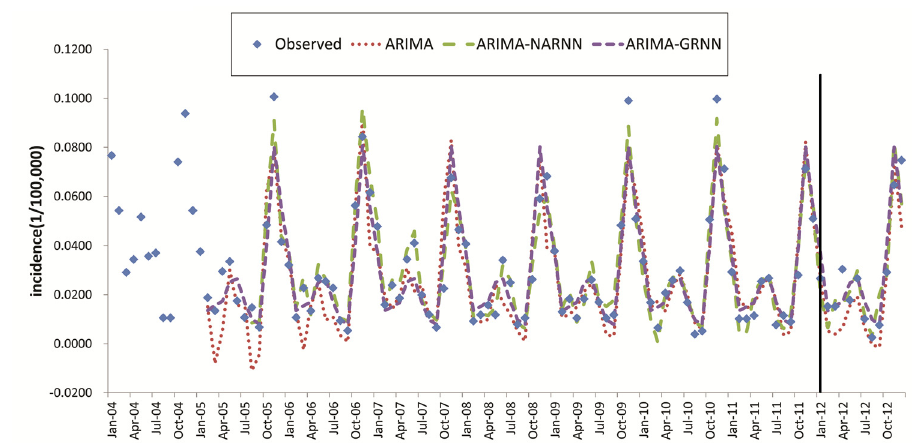
Fig 7. The observed HFRS incidence and modeling and forecasting values simulated by ARIMA, ARIMA-NARNN and ARIMA-GRNN model. The data set was divided into modeling and forecasting data set with a vertical line; the left is the modeling stage, and the right is the forecasting stage.